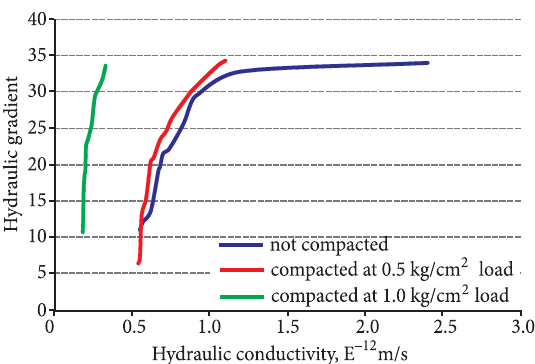
Fig. 5. Dependence on the hydraulic gradient and the hydraulic conductivity of natural structure